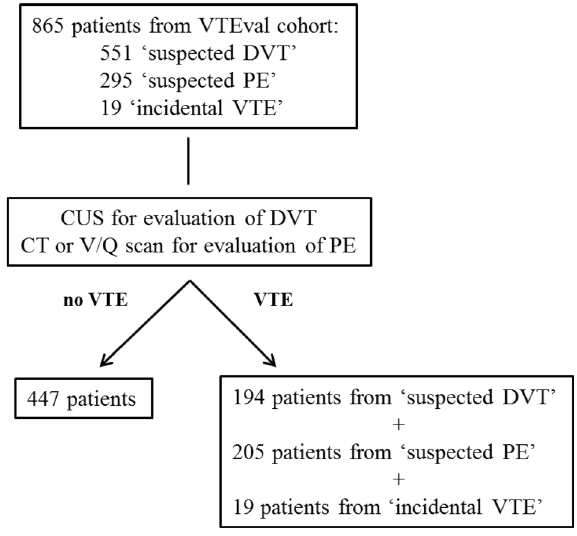
Figure 1. Consort flow chart. DVT, deep vein thrombosis; PE, pulmonary embolism; VTE, venous thromboembolism; CUS, compression ultrasound; V/Q scan, ventilation-perfusion scintigraphy; CT, computed